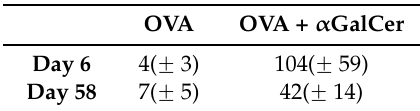
Table 2. Average number (± std. dev) of antigen-specific CD8 + T cells isolated from the FRT of immunized mice.